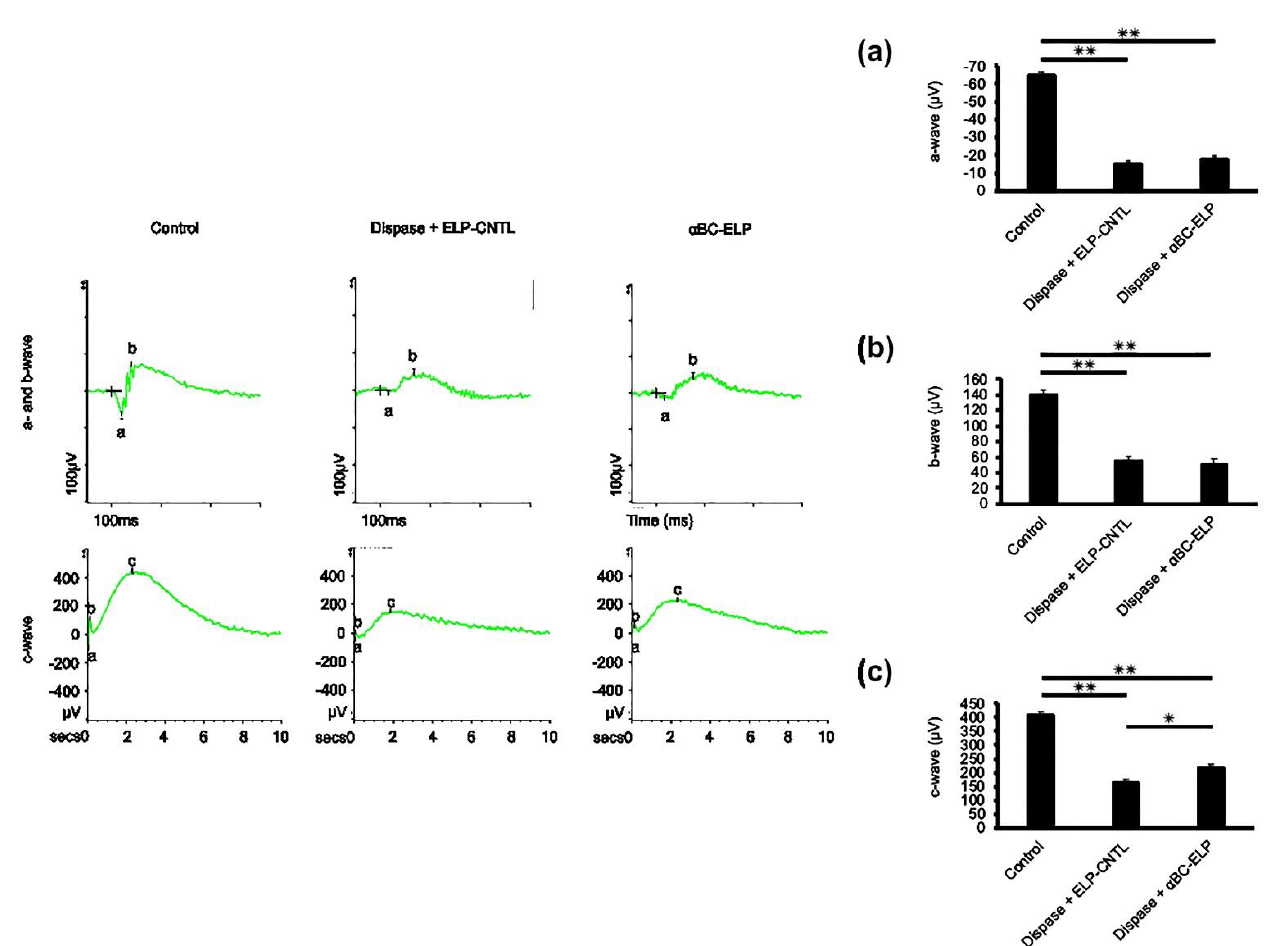
Figure 9. Effect of αBC -ELP on photoreceptor function by ERG. The experimental protocol is shown in Figure 8a. Electroretinogram (ERG) analysis of mice treated with and without αBC -ELP ( a,b,c ). The ‘ a ’— wave represents the hyperpolarization of photoreceptors ( a ), the ‘ b ’ wave represents the second-order neuron response ( b ), and the ‘ c ’ wave represents light-induced activity in the photoreceptors ( c ). Three groups were compared: (1) wild-type with PBS as control, (2) dispase (1 μL, 5 mg/mL) + ELP-CNTL treated, (3) dispase (1 μL, 5 mg/mL) + αBC -ELP (1 μL from 218 μM). While there is no change in ( a , b ) waves, ( c ) wave amplitude significantly improved with αBC -ELP. Values are the means ± SE. αBC - ELP: αB crystallin -elastin-like polypeptide. * p < 0.05, ** p < 0.005. n = 3.